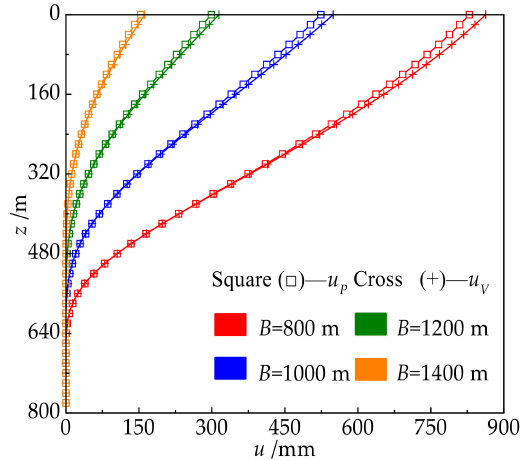
Figure 9. The shaft horizontal displacement curve ( n = 6).